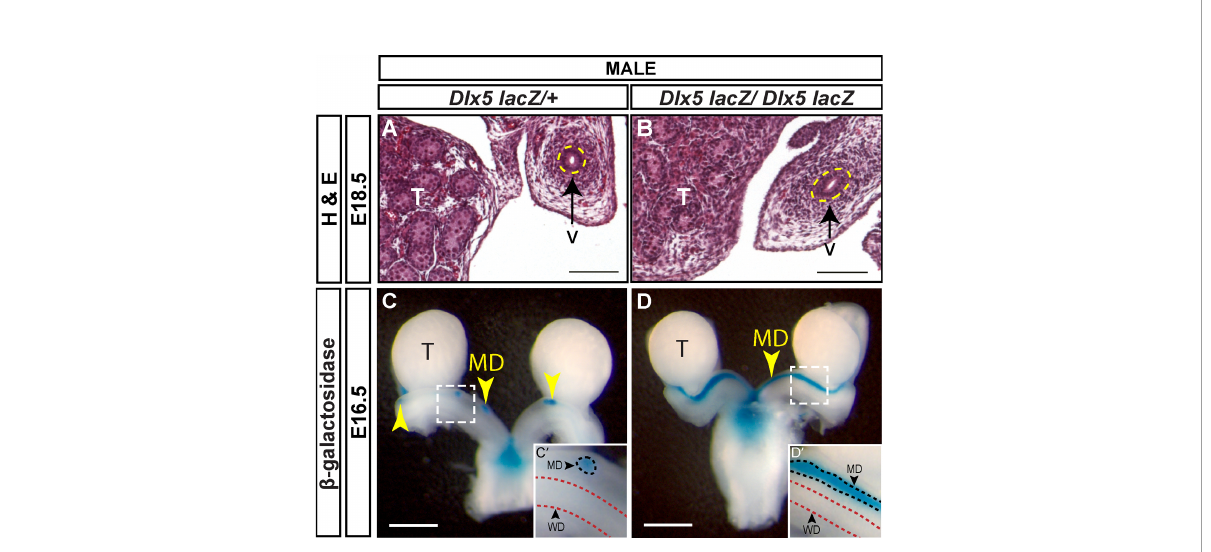
FIGURE 5 Defects in Müllerian regression are observed in some Dlx5 mutants at E16.5 but are resolved by E18.5. Hematoxylin (H) and Eosin (E) stained cross sections of the vas deferens (v) adjacent to the testis (T) from E18.5 Dlx5-lacZ/+ (A) and Dlx5-lacZ/Dlx5-lacZ (B) male embryos. Yellow dotted lines surround the vas deferens epithelium. Scale = 100 µm. Wholemount b -gal-stained urogenital organs from E16.5 Dlx5-lacZ/+ (C) and Dlx5-lacZ/Dlx5-lacZ (D) male embryos. Yellow arrowheads, Müllerian ducts. T, testis; MD, Müllerian duct. Scale bars = 500 µm. (C ’ , D ’ ) Higher magni fi cation insets. Arrowheads, Müllerian ducts, MD; Wolf fi an ducts, WD. Dotted lines surround MD (black) and WD (red). E18.5 each genotype analyzed (n=4); E16.5 Dlx5-lacZ/+ (n=5); E16.5 Dlx5-lacZ/lacZ (n=6).